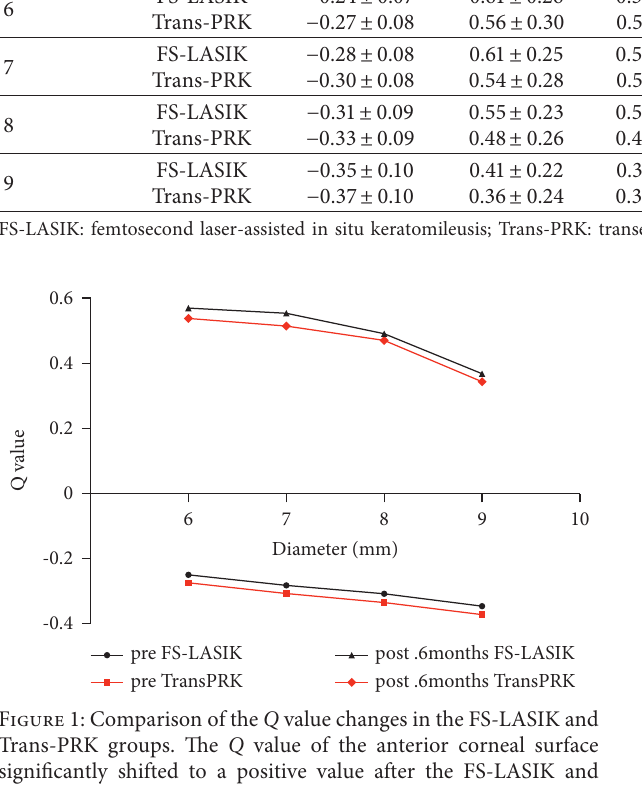
Table 2: Asphericity ( Q value) of the anterior corneal surface in FS-LASIK and Trans-PRK. Dia. (mm)